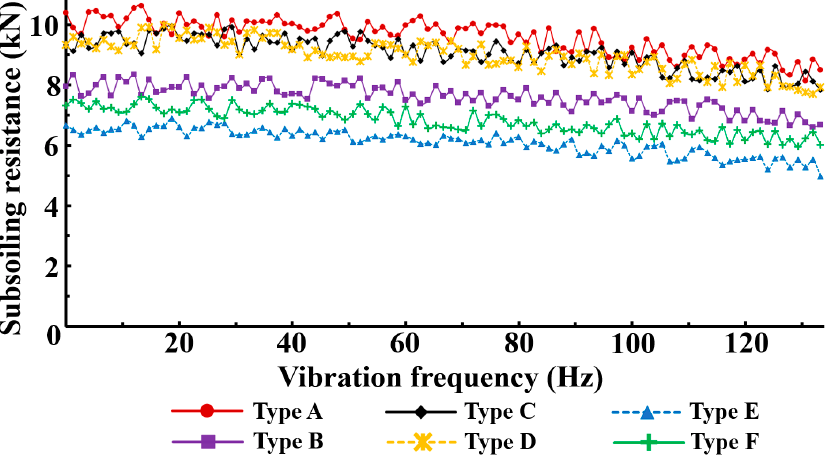
Figure 11. Variation of subsoiling resistance with the vibration frequency of six shovel tips at 7 km/h speed.